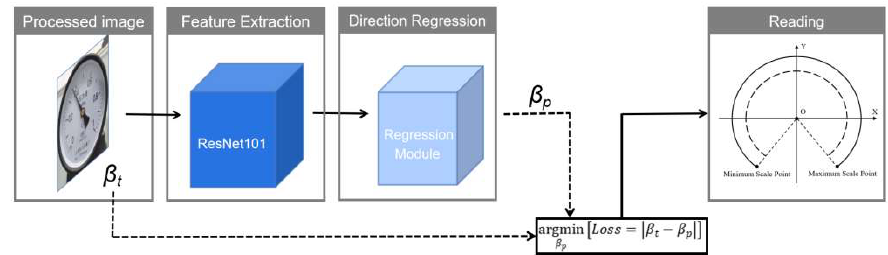
Figure 6. Flow chart of meter reading based on direction